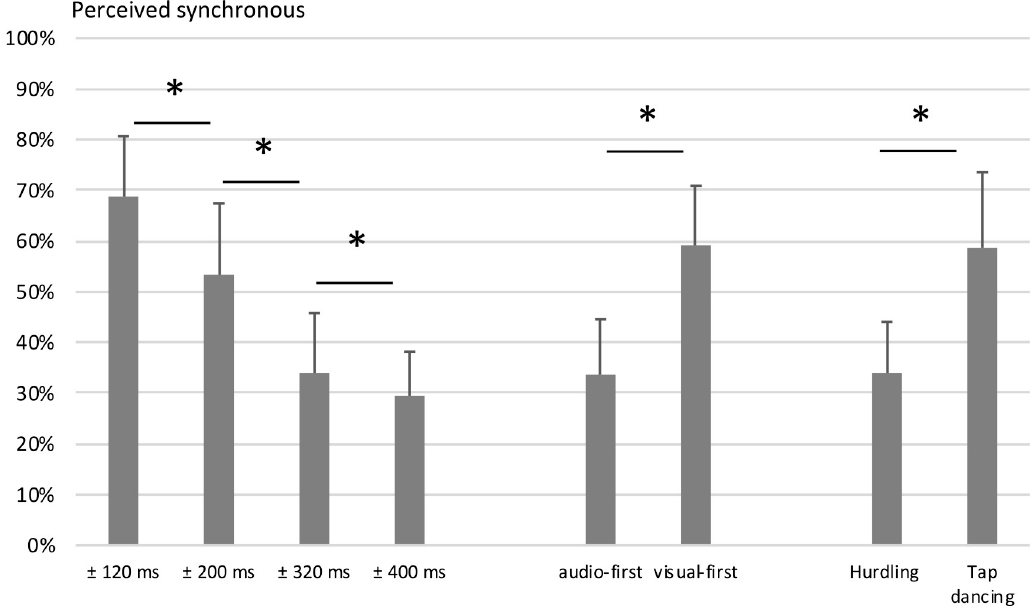
Fig 3. Main effects of audiovisual (a)synchrony ratings, Study 1. Displayed are the mean percentages of trials perceived as synchronous, aggregated for the factors asynchrony size, asynchrony type, and action type. Error bars show standard deviations. Statistically significant differences ( p < .001) are marked with